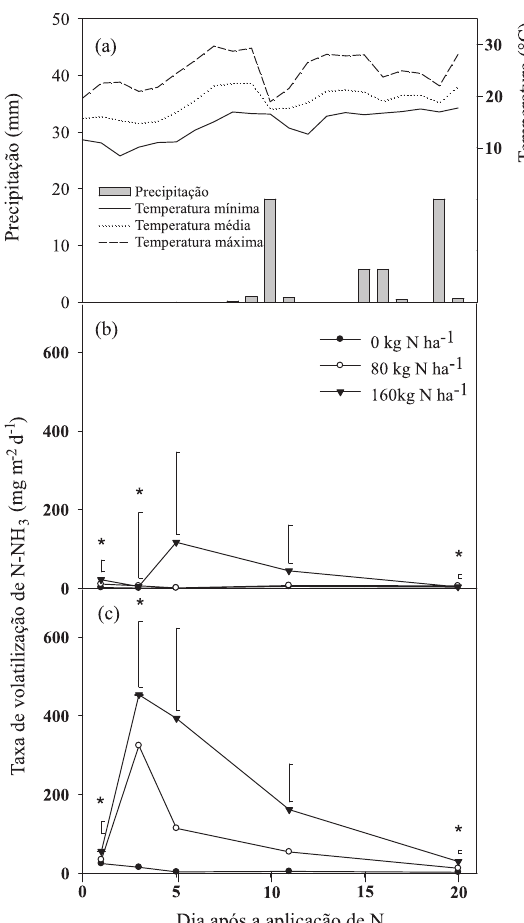
Figura 1. temperatura do ar (máxima, média e mínima) e precipitação pluvial no período posterior à aplicação de n-ureia (a) e taxas de volatilização de n-nH 3 oriundo do n-ureia aplicado na cultura do milho sob preparo convencional (b) e plantio direto (c). as barras verticais indicam diferença mínima significativa pelo teste de tukey, p > 0,05. * indica diferença significativa, na média das doses de n, entre preparo convencional e plantio direto (teste de tukey, p >